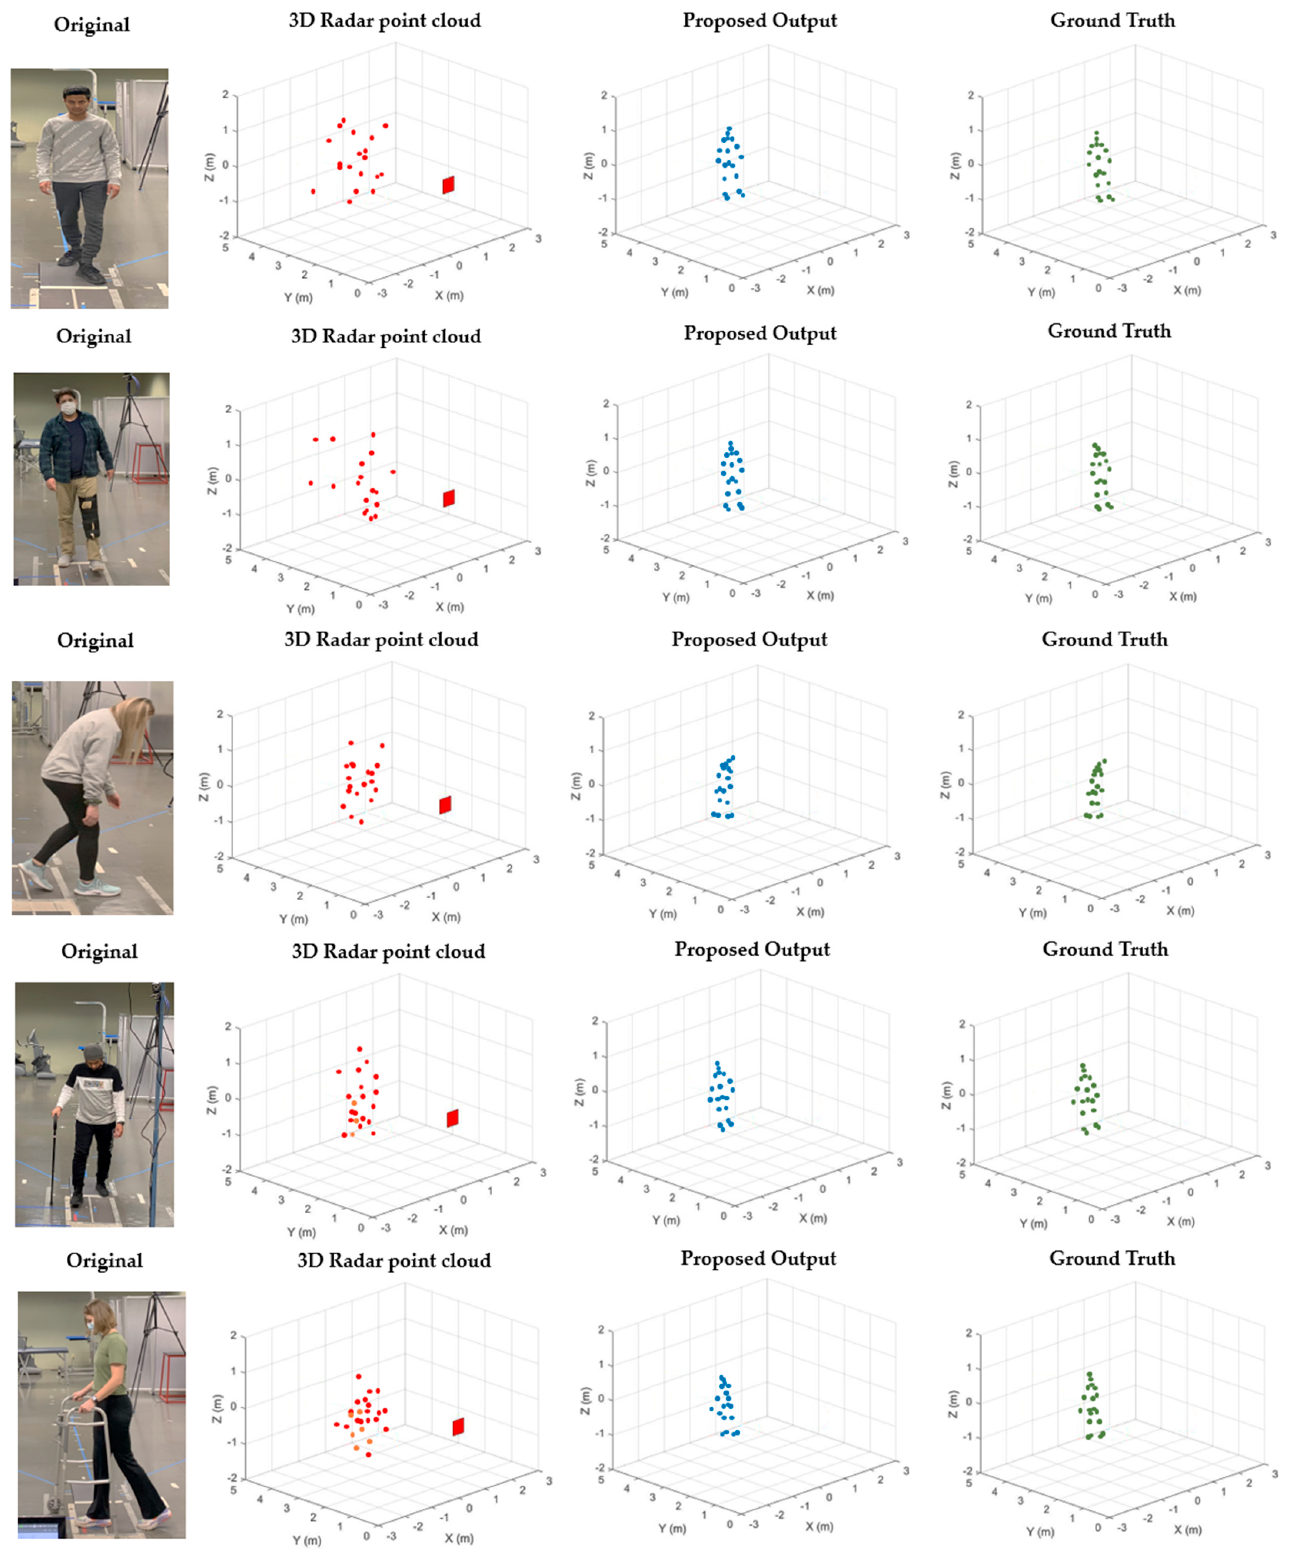
Figure 7. Proposed system for reconstructing human joints from a point cloud. ( Left ) (MMW radar point clouds), ( middle ) (Proposed estimation), ( right ) (Kinect ground truth).